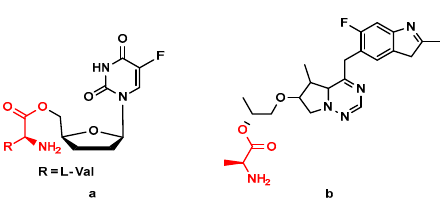
Figure 2. The structures of floxuridine prodrug ( a ) and brivanib ( b ).